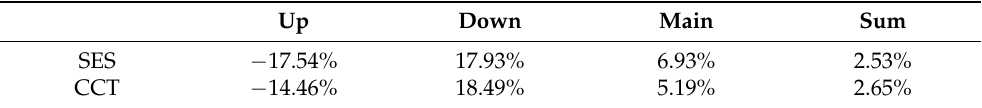
Table 2. Relative variation in